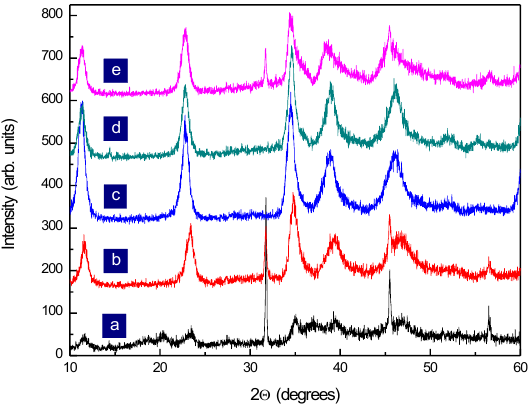
Fig. 1. XRD powder pattern of the products prepared at different pH values a: 8, b: 9, c: 10, d: 11, e: 12.5